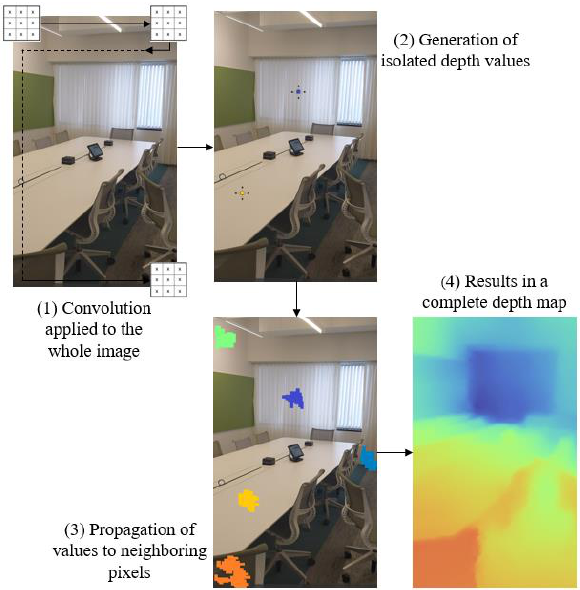
Figure 3. Process for creating depth maps within